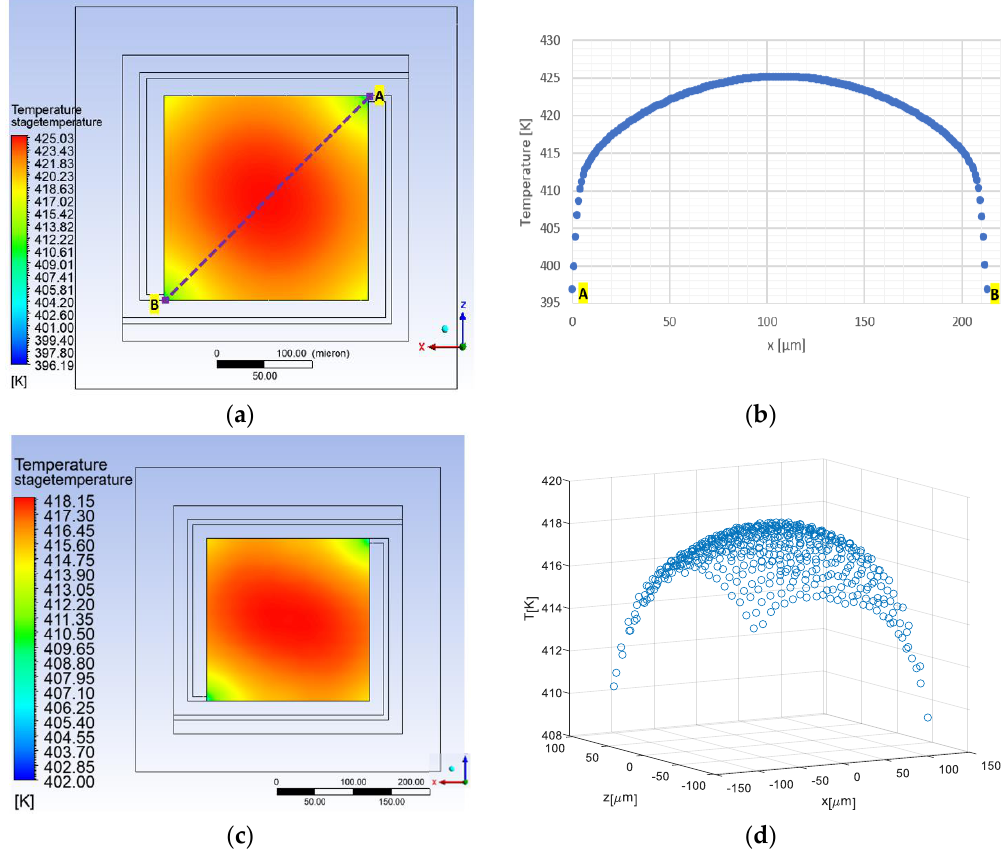
Figure 5. Steady-state thermal simulation results of the DUT design for V heater = 3 V, and R heater = 1000 ohm: ( a ) Distribution of the temperature over the bare plate. ( b ) The temperature of the plate among the line between point x and y in Figure 5a. ( c ) 2-D temperature distribution over plate with platinum catalytic layer and silicon nitride. ( d ) 3-D temperature distribution over the plate with platinum and silicon nitride layers.